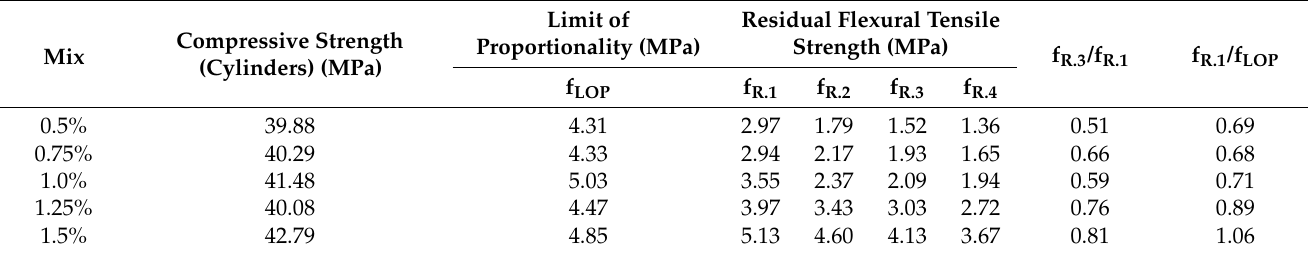
Table 4. Results of the flexural